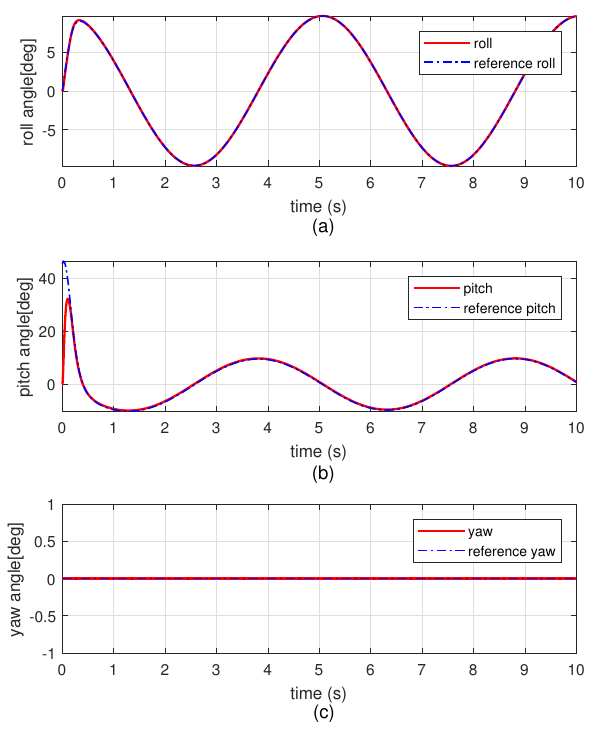
Figure 10. The attitude response for the trajectory tracking control. The dashed line indicates the reference attitude angles that enable the quadrotor to converge in the desired trajectory, and the solid line is the result of the simulation about attitude responses of a quadrotor: ( a ) θ ; ( b ) ψ ; ( c ) φ